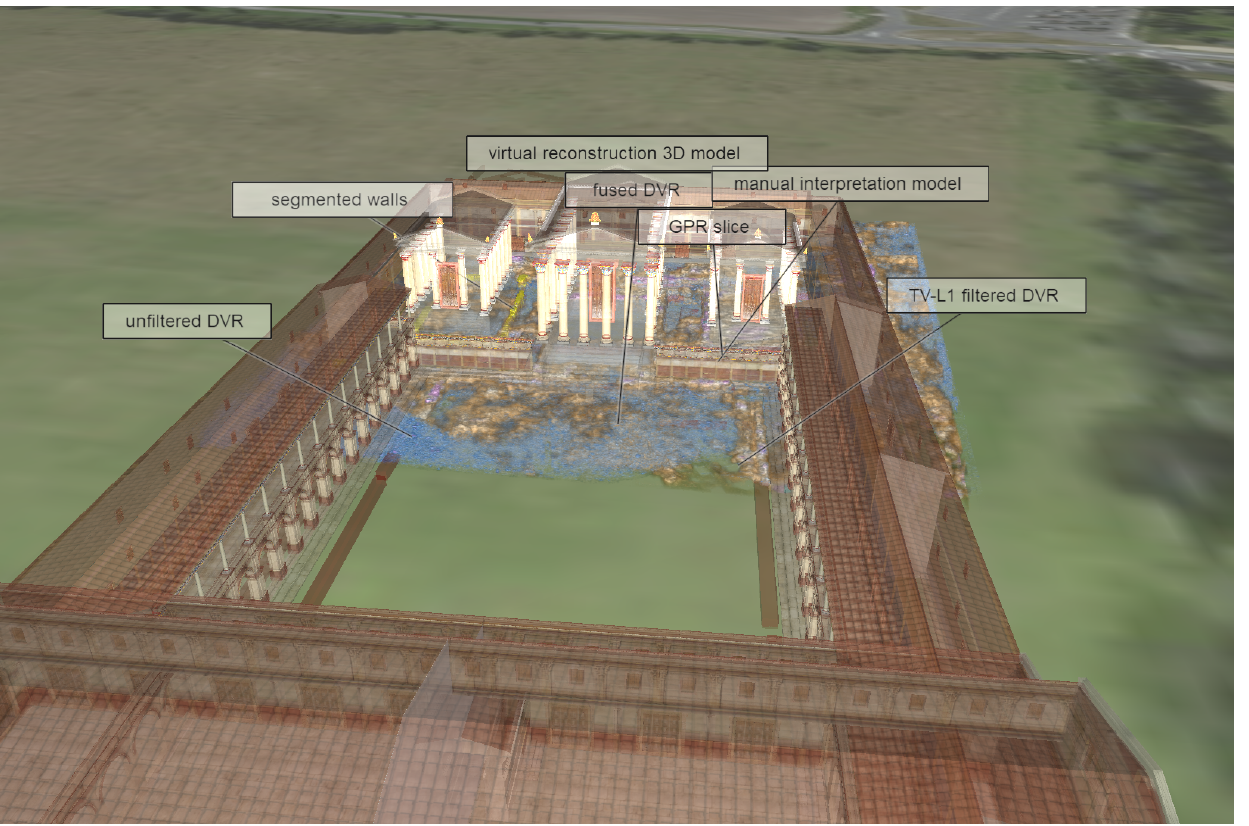
Figure 15. Result image combining multiple versions of the GPR dataset, a 3D interpretation model of the walls, segmented walls, and the reconstructed model. All the datasets are visualized together with a 3D terrain